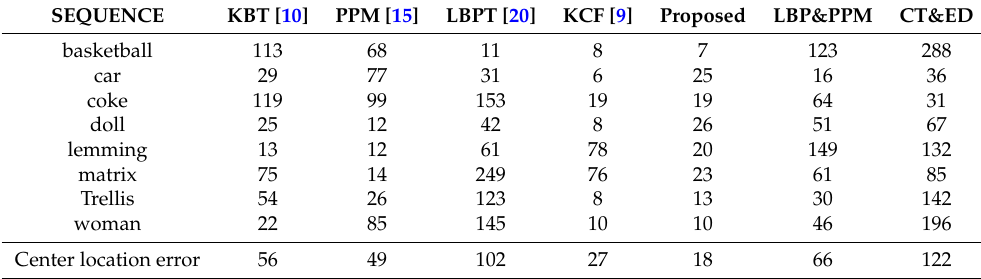
Table 5. Center location errors of the proposed method compared with the other trackers